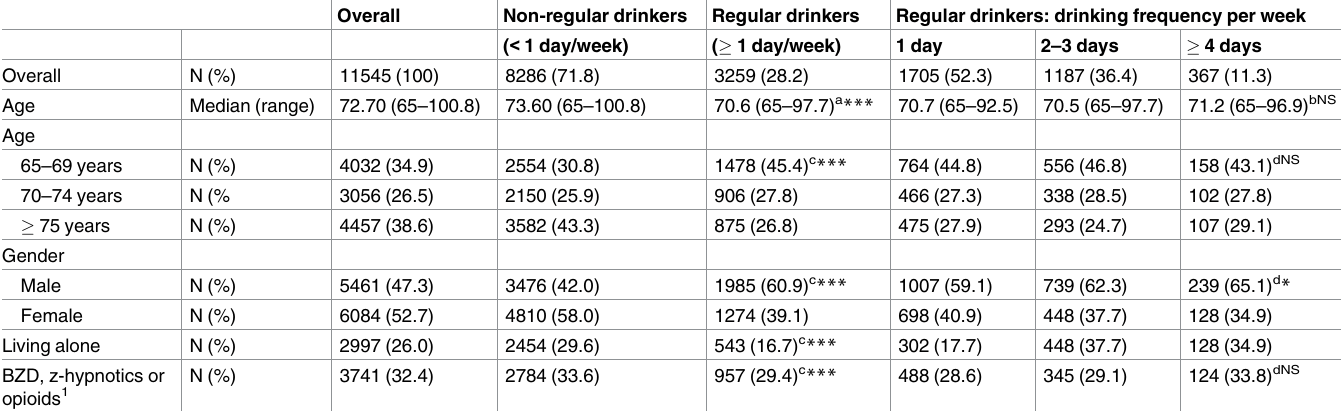
Table 1. Overall sample characteristics and drinking status in older Norwegian adults ( (cid:21) 65 years, N = 11,545). The HUNT Study 2006–08(HUNT3). Overall Non-regular drinkers Regular drinkers Regular drinkers: drinking frequency per